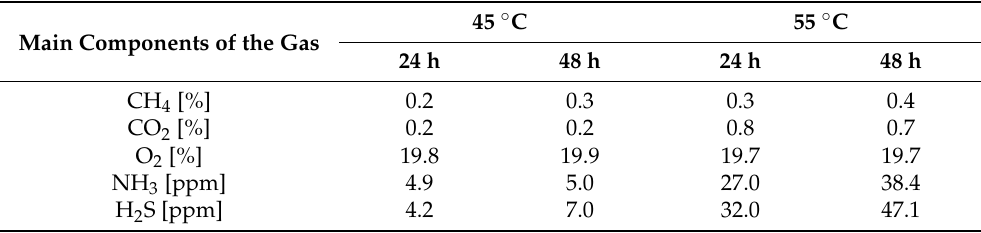
Table 4. Reaction gas parameters measured during the low-temperature disintegration process for the tested